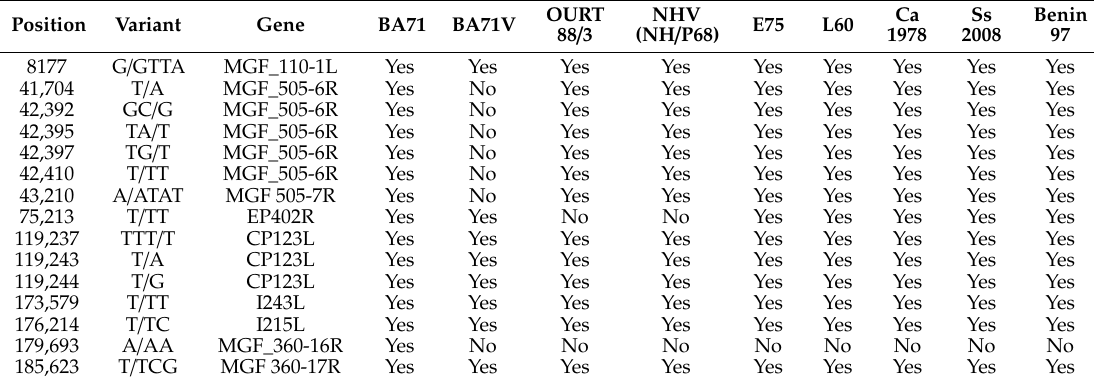
Table 10. Unique mutations found within open reading frames of Arm / 07 / CBM / c4 relative to genotype I strains (excluding Mkuzi 1979 and Liv13 /